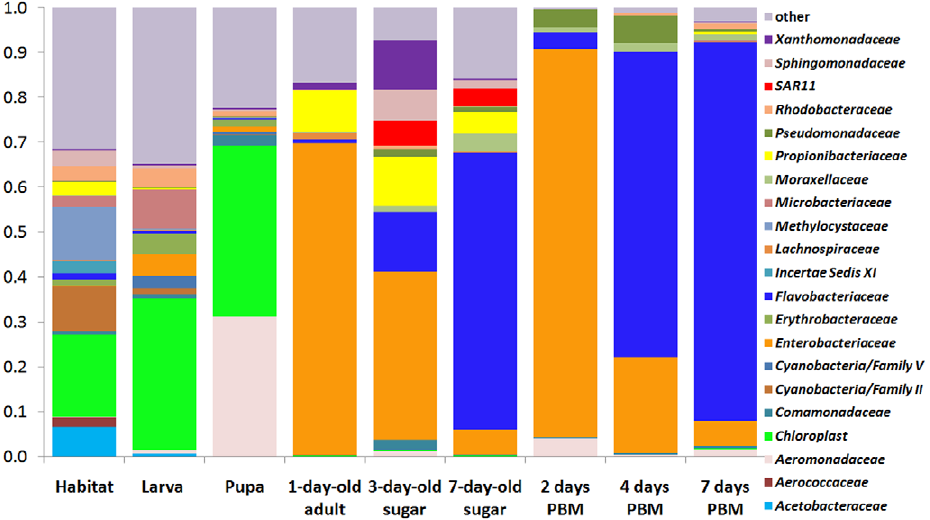
Figure 3. Gut bacterial composition at family level in different life stages of An.gambiae in Kenya. Families with abundance of $ 2% in at least one sample are presented. Taxa with abundance of , 2% were pooled together as ‘‘Other’’. Sugar, fed with sugar meal; PBM, post blood meal.